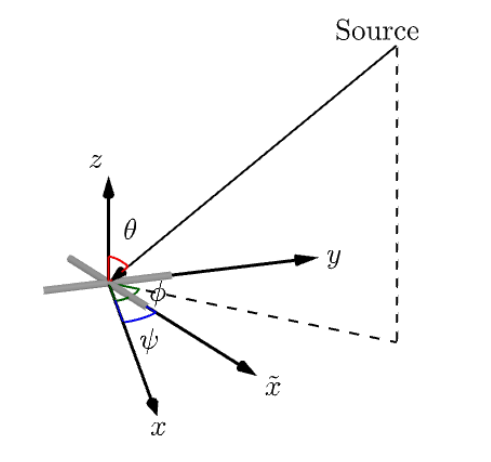
Figure 1. Diagrammatic representation of the skewed biaxial velocity